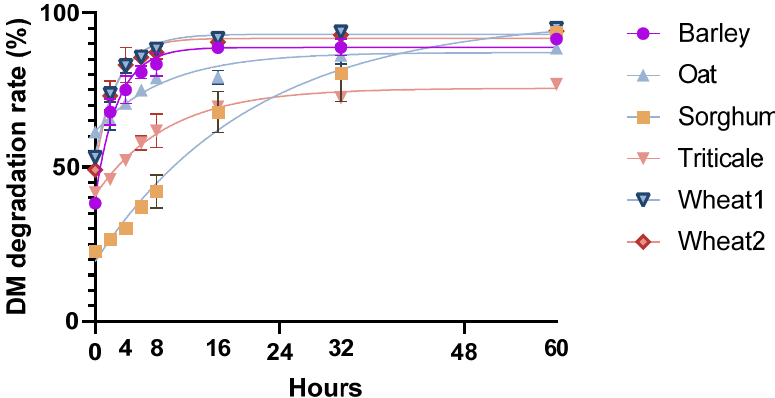
Figure 1. In situ disappearance pattern of DM (dry matter) in six ground grains.